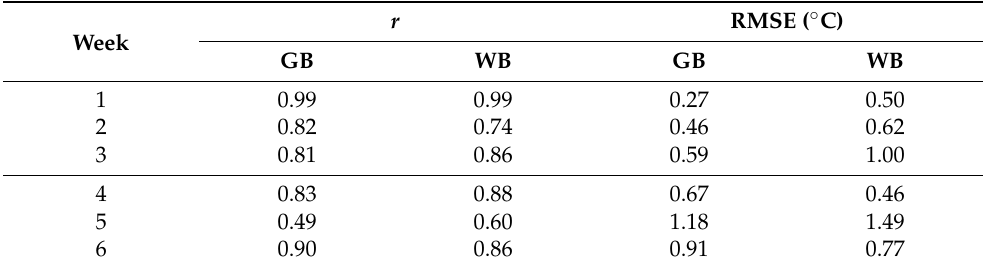
Table 6. Calculated error for both GB and WB models during calibration (weeks 1–3) and validation (weeks